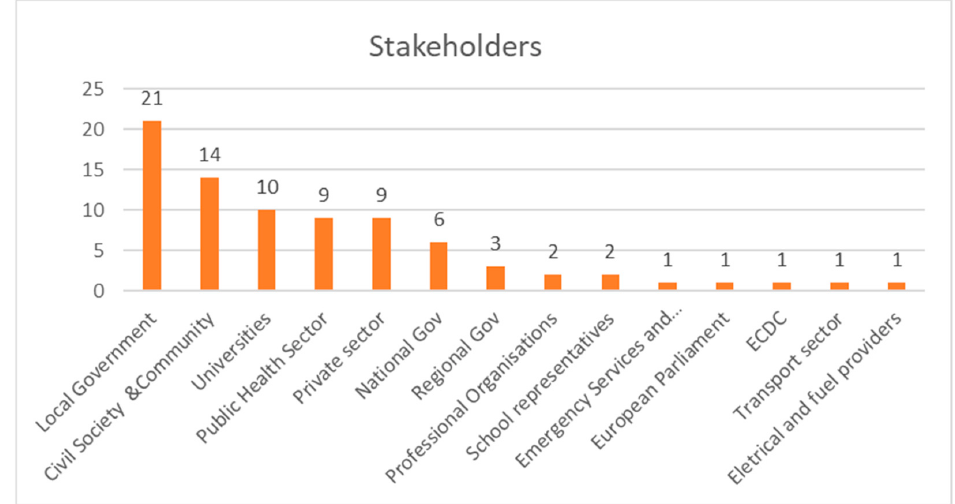
Scheme 4. Types of stakeholders identified in the selected